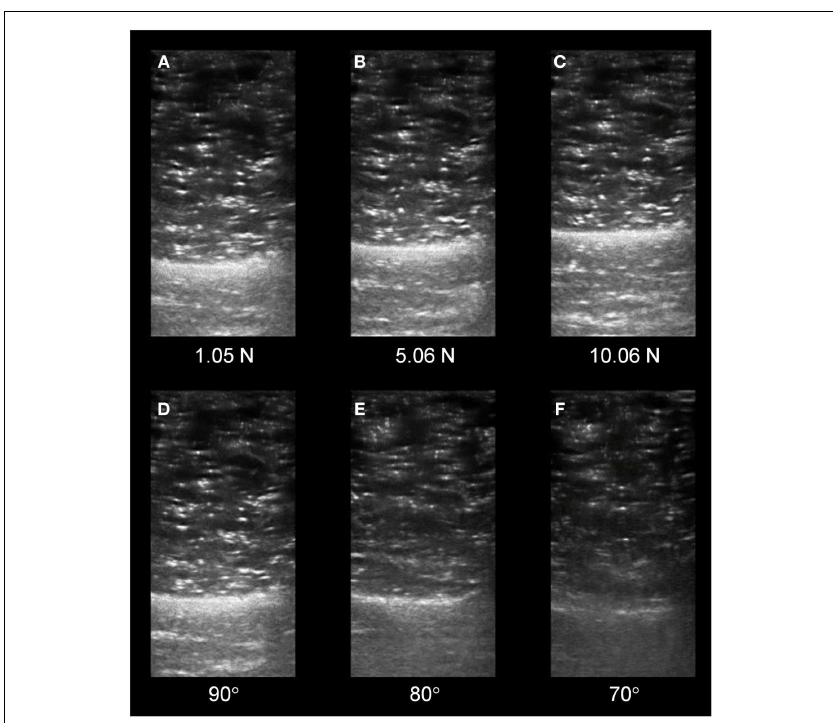
FIGURE 1 | Changes in serial sonographic image characteristics based on examiner force and sound transducer orientation . (A–C) Depict transverse views of a muscle tissue mimetic phantom with a progressive magnitude of stress imposed on the phantom surface by the sound transducer.The material deformation (thickness, centimeter) secondary to the stress progression was as follows: (A) 3.78cm, (B) 3.45cm, and (C) 3.21cm. (D–F) Depict similar sonographic views as the preceding panels.The echointensity observed in the serial images is based on a progressively increasing cranial/caudal tilt angle of the sound transducer applied to the phantom surface.The changes in echointensity (grayscale, unitless, 0–255) secondary to the angle progression were as follows: (D) 56.64, (E) 48.10, and (F) 36.90. (All images were acquired using a 6MHz linear array sound transducer and a muscle mimetic phantom with anechoic gel via automated image capture by the Kuka LWA